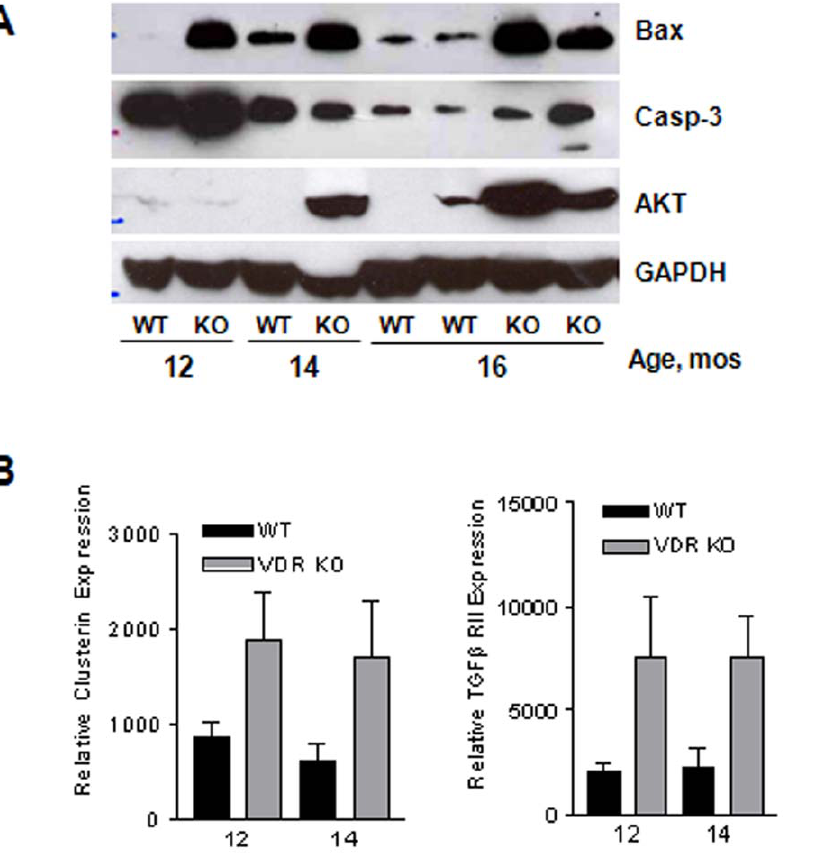
Figure 6. Assessment of apoptotic and survival related proteins in aging mammary glands from WT and VDR KO mice. A. Western blot of Bax, caspase-3, and AKT expression during aging development. VDR KO glands have a higher Bax expression at all aging time points, suggesting a possible increase in apoptosis in aging VDR KO glands. Caspase-3 and AKT expression are also elevated in VDR KO mice, particularly at 14 and 16 months. GAPDH serves as a loading control. B. Real Time PCR for Clusterin and TGF b II gene expression in aging mammary glands (12 and 14 months) derived from WT and VDR KO mice. Data are expressed relative to 18S RNA (Relative Gene Expression) and represent mean 6 s.e.m. of triplicate